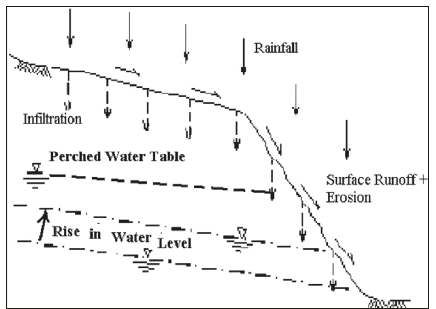
Figure 2: Rainfall induced landslide [8].